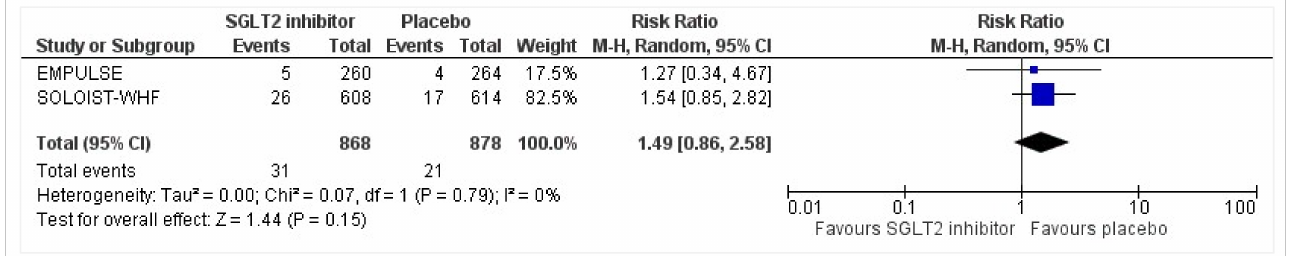
Figure 10. Forest plot for the total number of patients who had hypotension as a serious adverse event in either group [25–27].